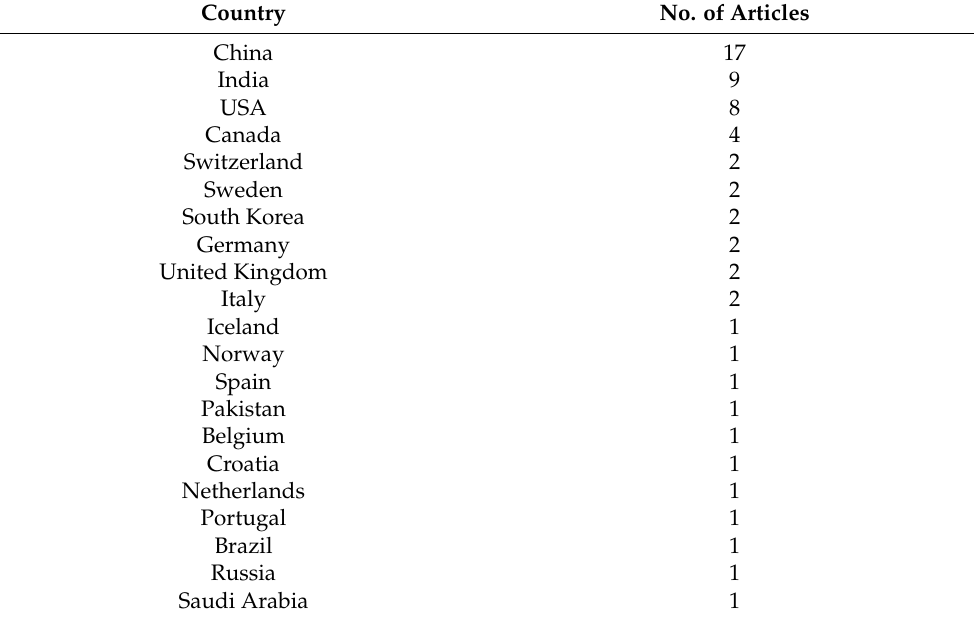
Figure 5. Research studies included in the review by region. Note: research for some articles was conducted in more than 1 country, that is why the sum is not equal to the number of articles included in the review. Table 3. Articles included in the review by country.